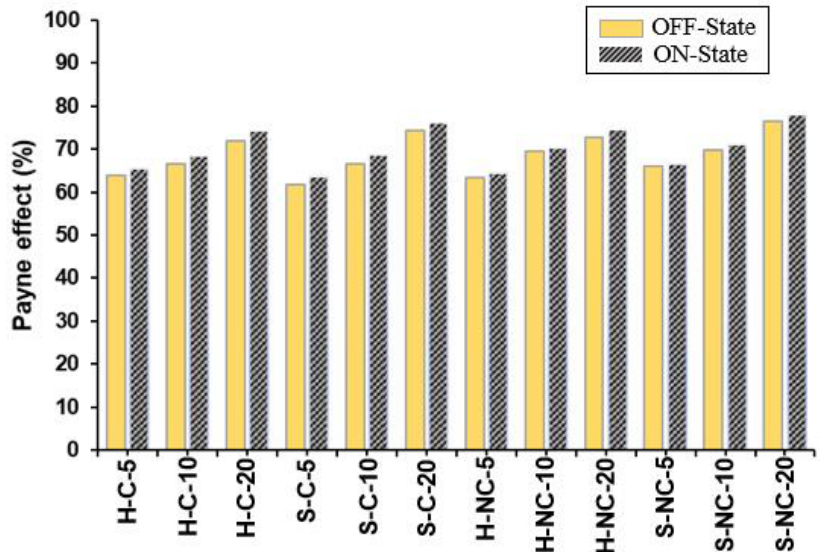
Figure 10. Comparison of the Payne effect of MREs with different combinations of CIP types and volume fractions.